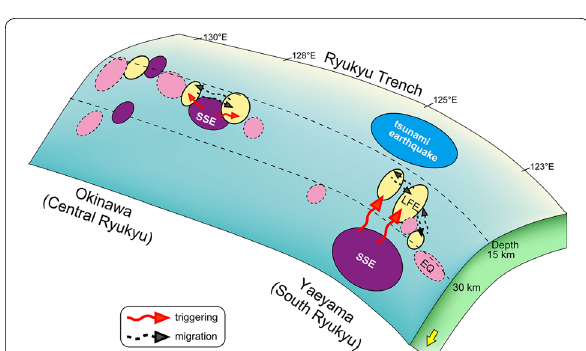
Fig. 14 Schematic diagram illustrating the distribution of slow earthquakes in the Ryukyu Subduction Zone. Pink circular areas with dotted lines show the areas of ordinary thrust-type earthquakes. Yel- low circular areas show the areas of low-frequency earthquakes (LFEs). Purple circular areas show the slow slip event (SSE) faults (Nishimura 2014). Blue oval denotes the source area of the 1771 Yaeyama tsunami earthquake (Nakamura 2009). Red arrows show the triggering of LFEs by SSEs. Black arrows with dotted lines show the migration of